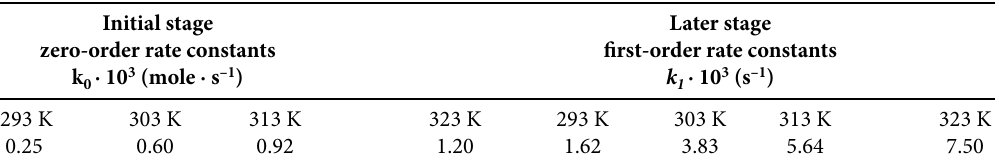
Table 1. Dependence of the rate constants at various temperatures for different stages of silver nanoparticles formation using PTHQ Initial stage